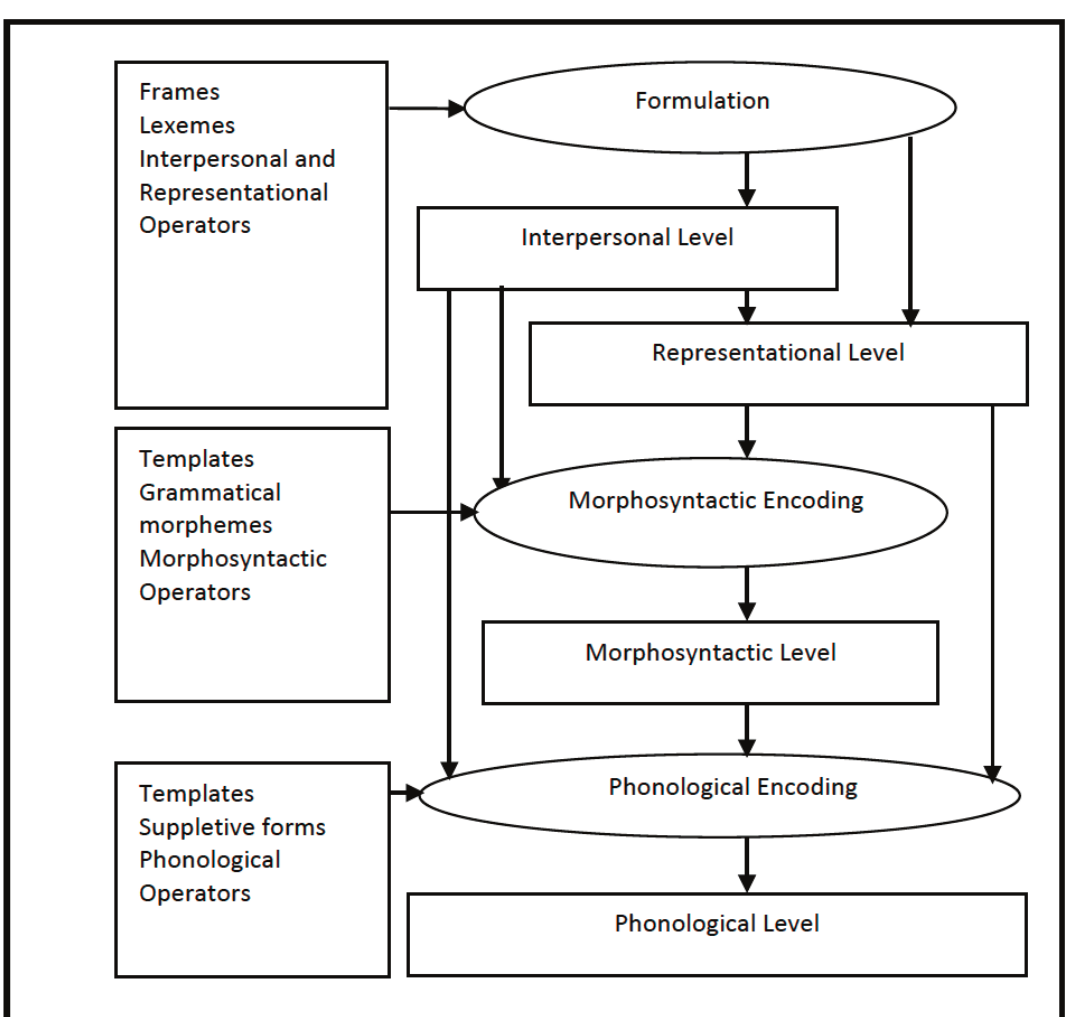
Figure 1. Outline of